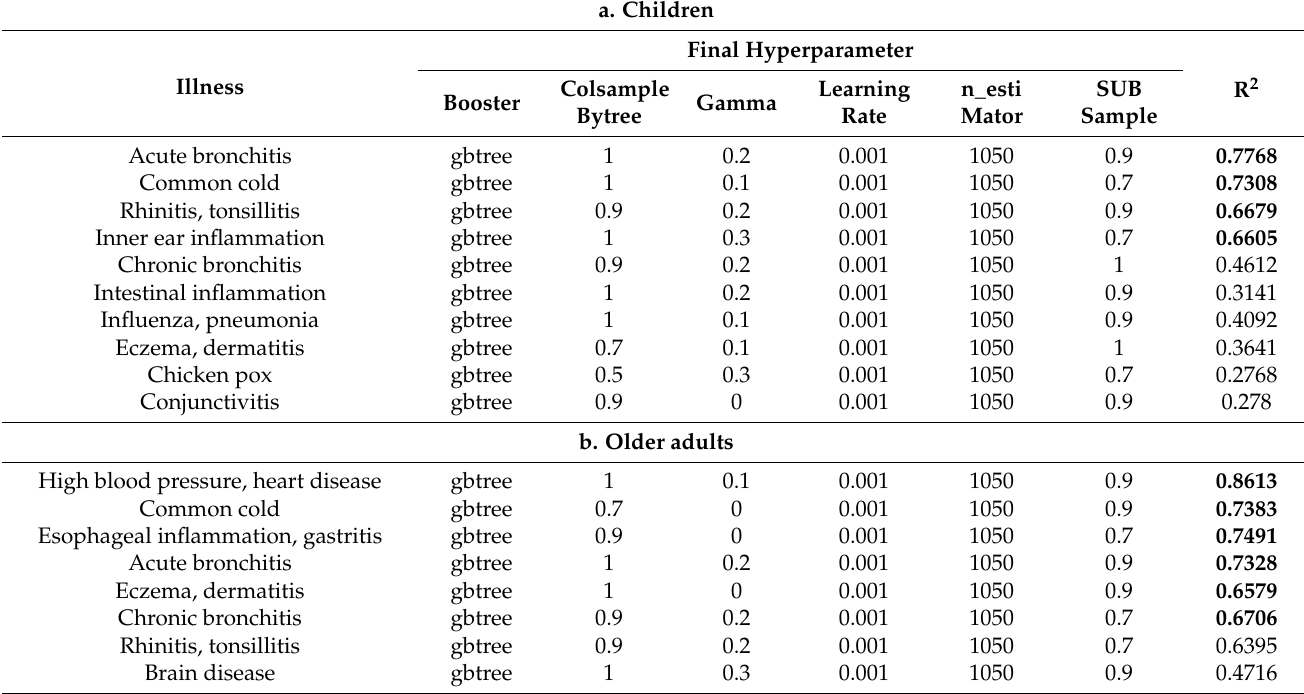
Table 5. Final hyperparameter for each